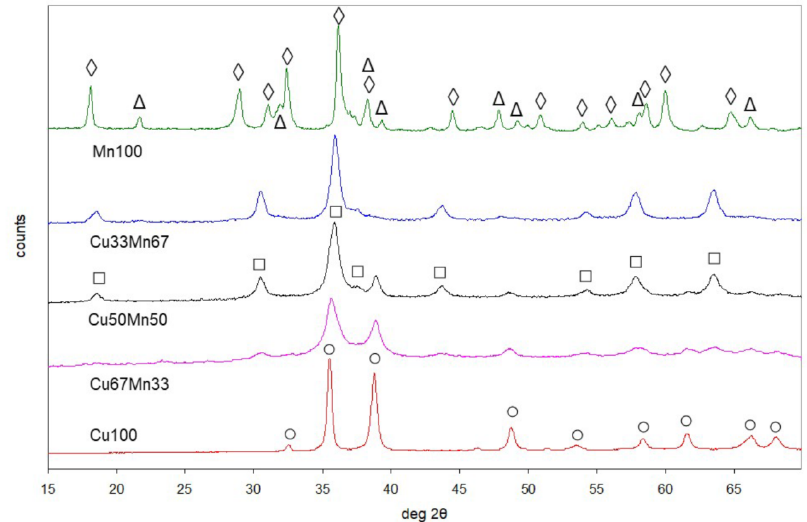
), cubic spinel ( (cid:3) ), Mn 3 O 4 (cid:35)